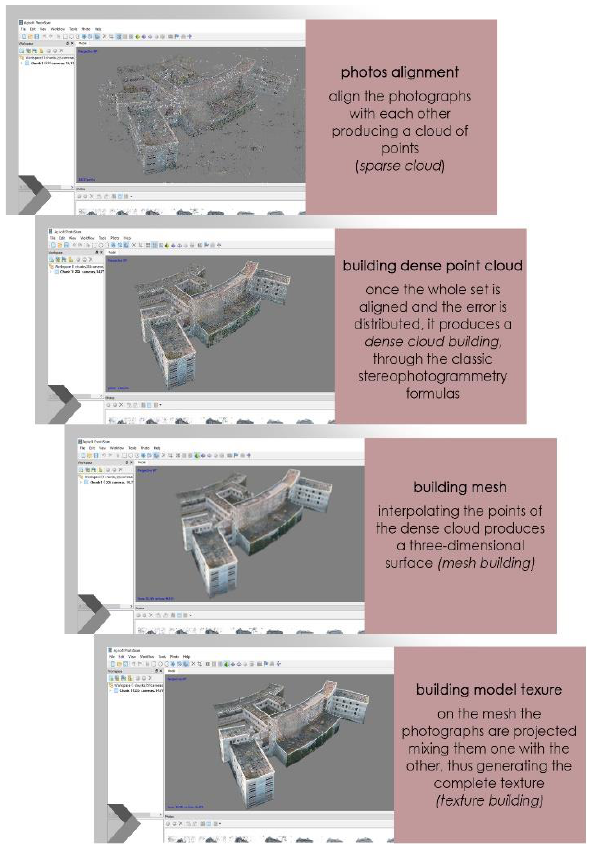
Figure 16. Modelling process.